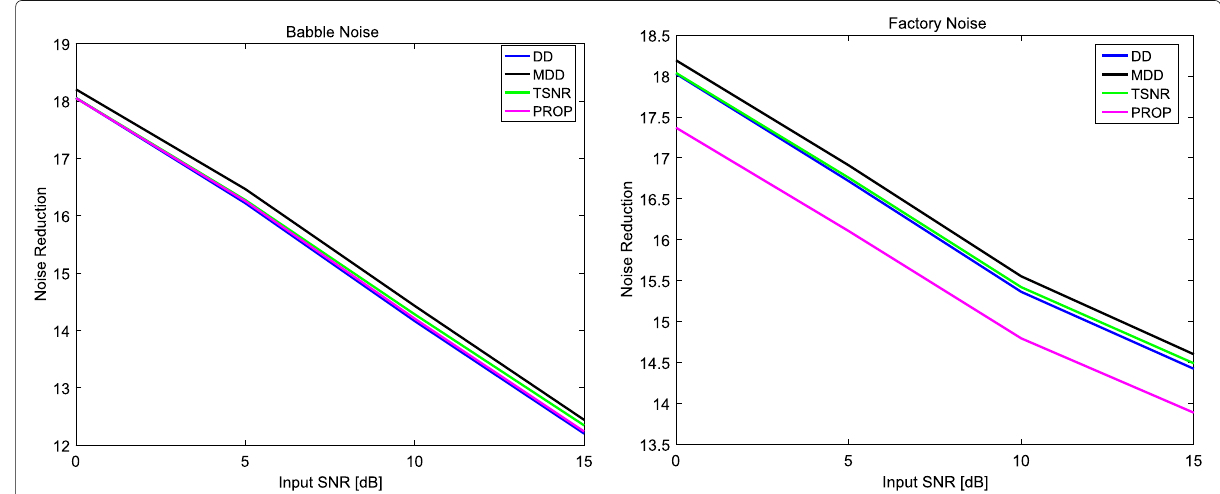
Fig. 6 Noise reduction measure for noisy speech corrupted with different noise types and under different SNR levels enhanced by Wiener filter speech estimation